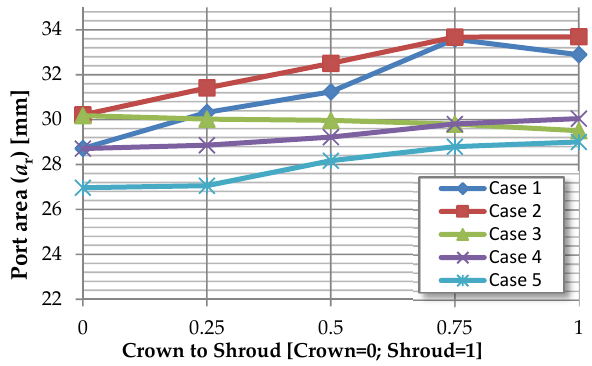
Figure 9. Port area distribution of the five cases.